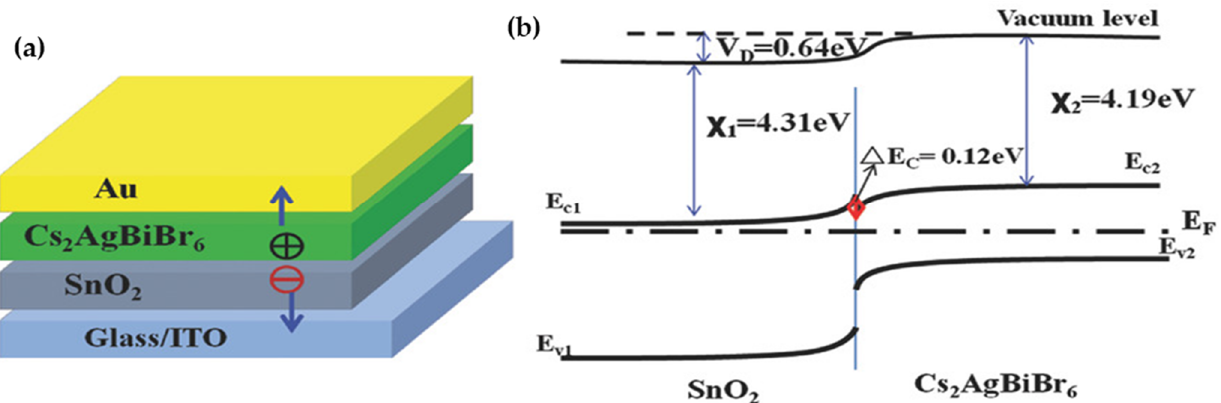
Figure 17. ( a ) Device configuration diagram and; ( b ) Band scheme diagram of Cs 2 AgBiBr 6 /SnO 2 heterojunction. Repro- duced with permission from [115]. Copyright 2018,